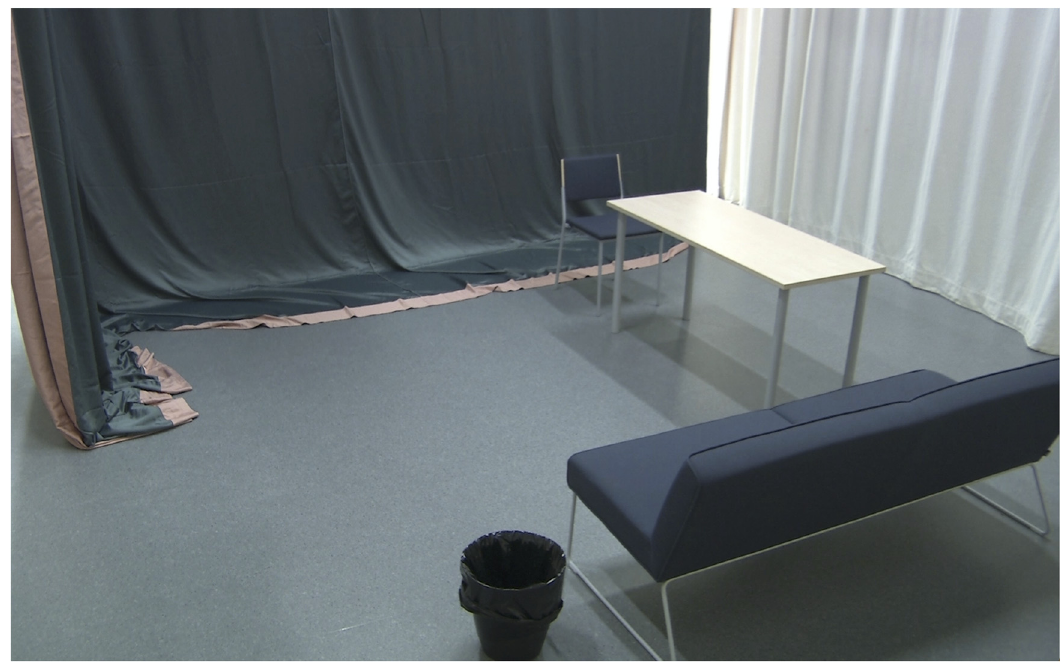
Figure 3: The room setting in the initial phase of the experiment.